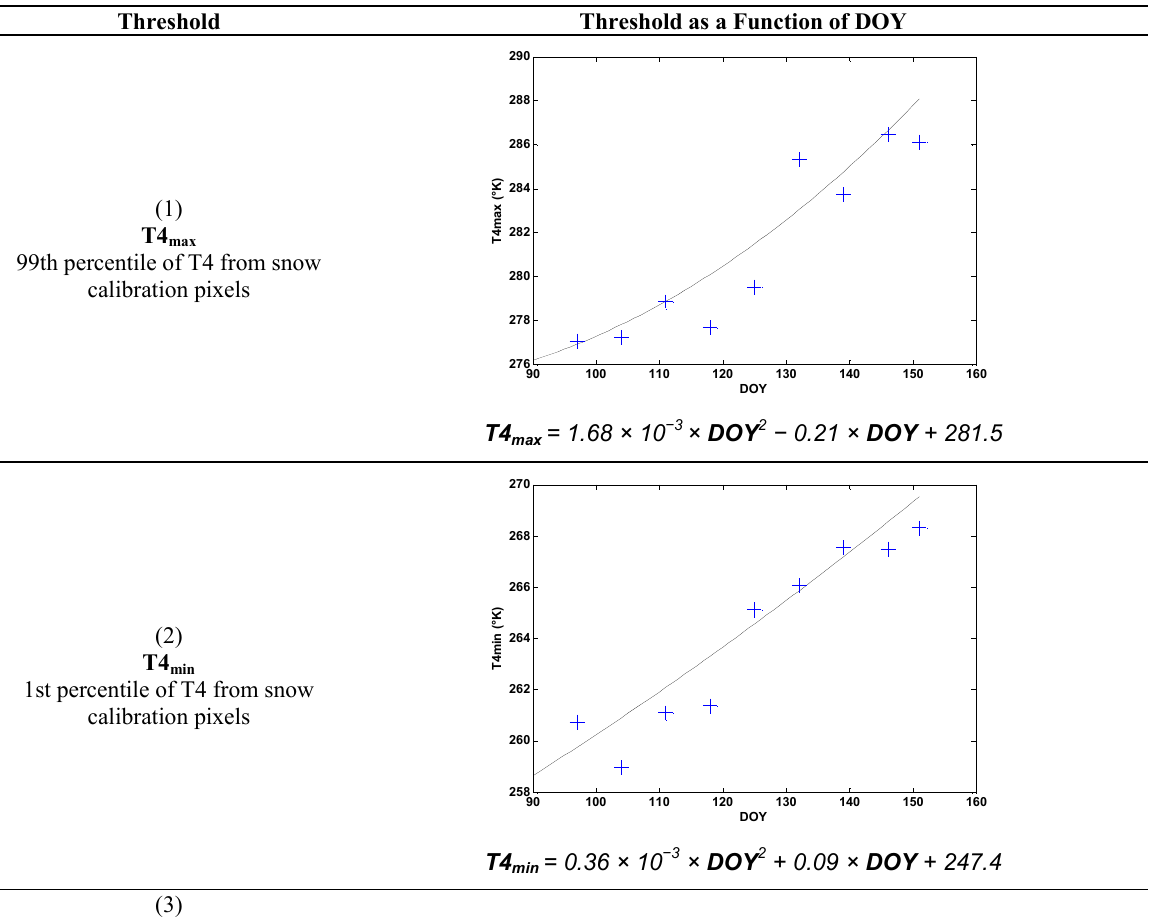
Table 1. Threshold values of the AVHRR algorithm. DOY, day of